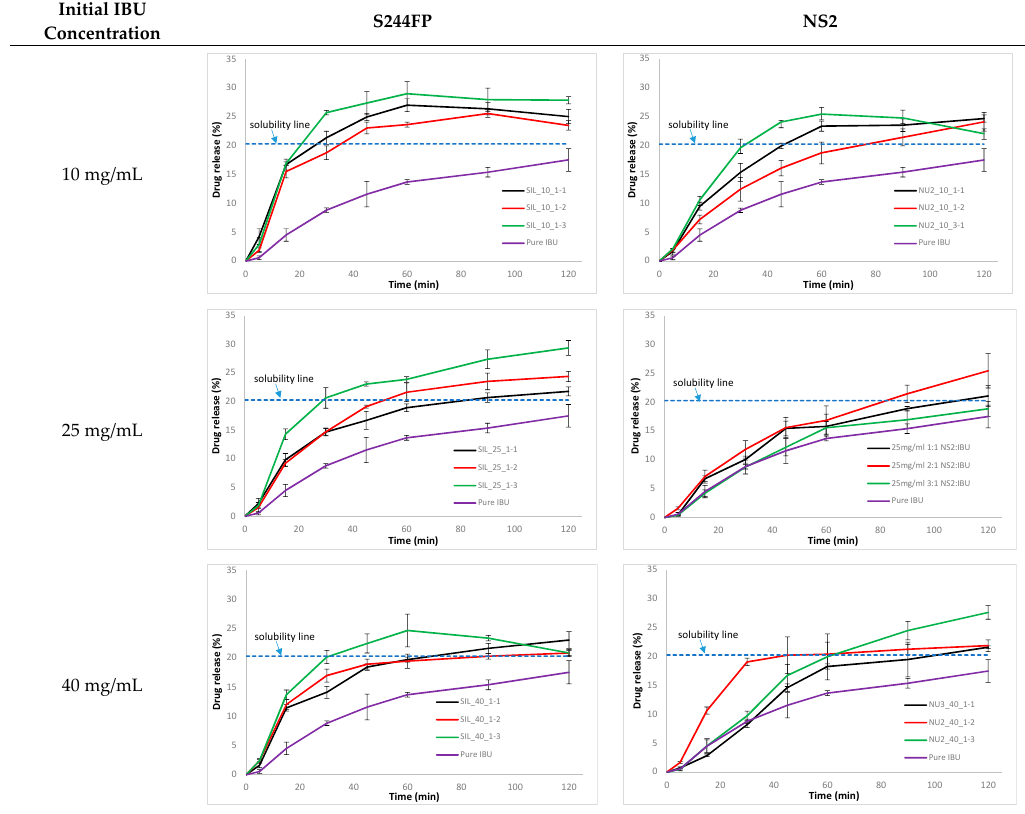
Figure 5. IBU dissolution profile from the drug-loaded carriers (refer to Table 1 for sample details).